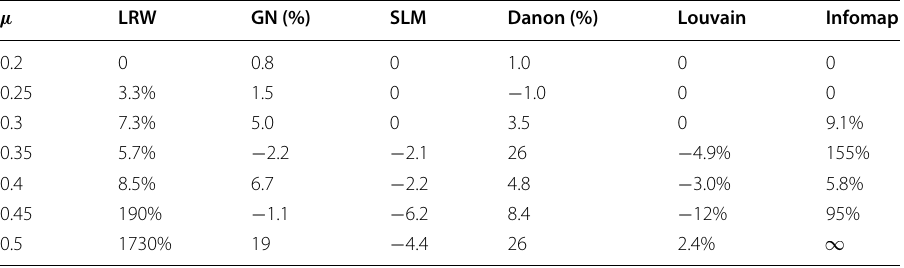
Table 6 Changes of normalized mutual information on graph clustering algorithms in per- centage